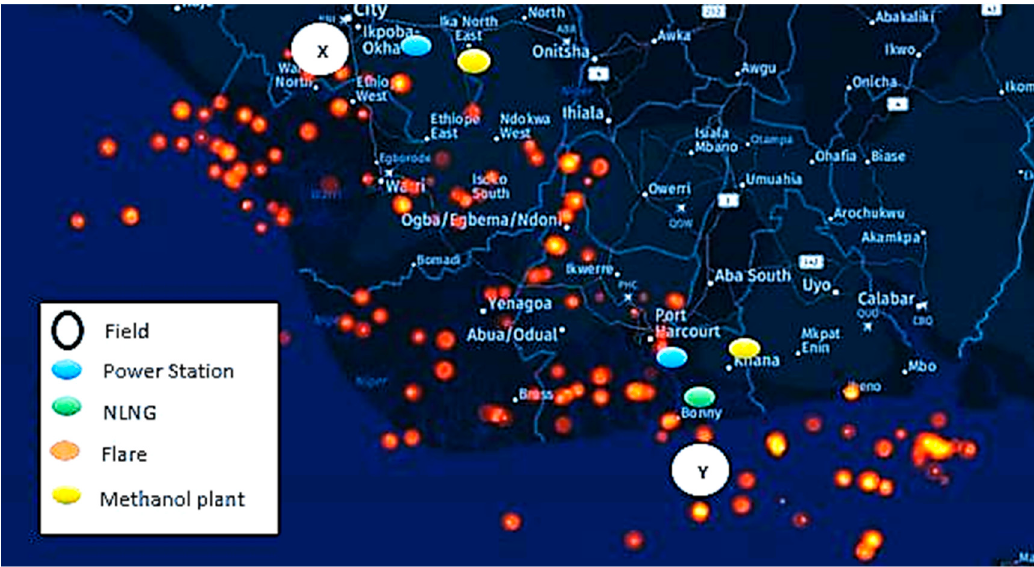
Figure 1. Location of gas flaring fields for this study in the Niger Delta region of Nigeria (adapted from [19].